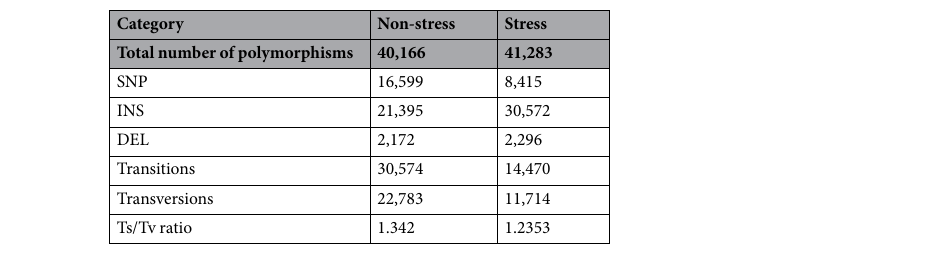
Table 1. Summary of polymorphisms identified in the non-stress and stress